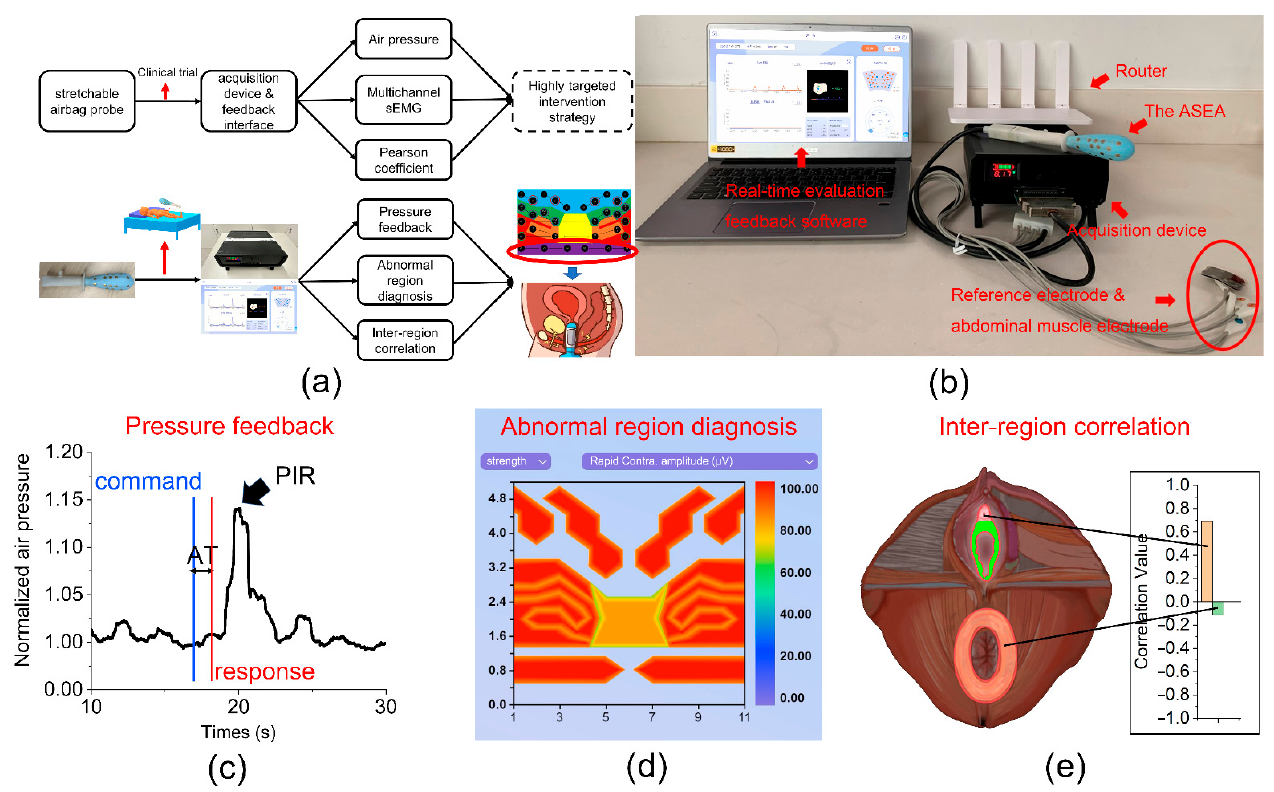
Figure 2. Detailed information of the MET. ( a ) The evaluation system framework of MET. The pressure and MC-sEMG data collected by ASEA based on Glazer protocol are submitted to the acquisition device and feedback interface for processing, and obtained the results of pressure feedback, abnormal area diagnosis contour map and interregional correlation. Targeted treatment strategy can be implemented in malfunction region. ( b ) System physical diagram. ( c ) Air pressure feedback waveform. AT is the time difference between the start of command (blue) and the start of response action (red). PIR is the growth rate of the air pressure in the contraction phase compared with the initial static air pressure. ( d ) PFM abnormal region diagnosis module. The functional parameter values of each region were presented on the contour map, and the color differences make the abnormal regions easy to be identified. ( e ) Inter-regional correlation analysis module. After determining the abnormal region, calculate the correlation value between the area and the nearby regions. The larger absolute value represented the closer relationship, and the positive and negative signs represented the cooperation and confrontation